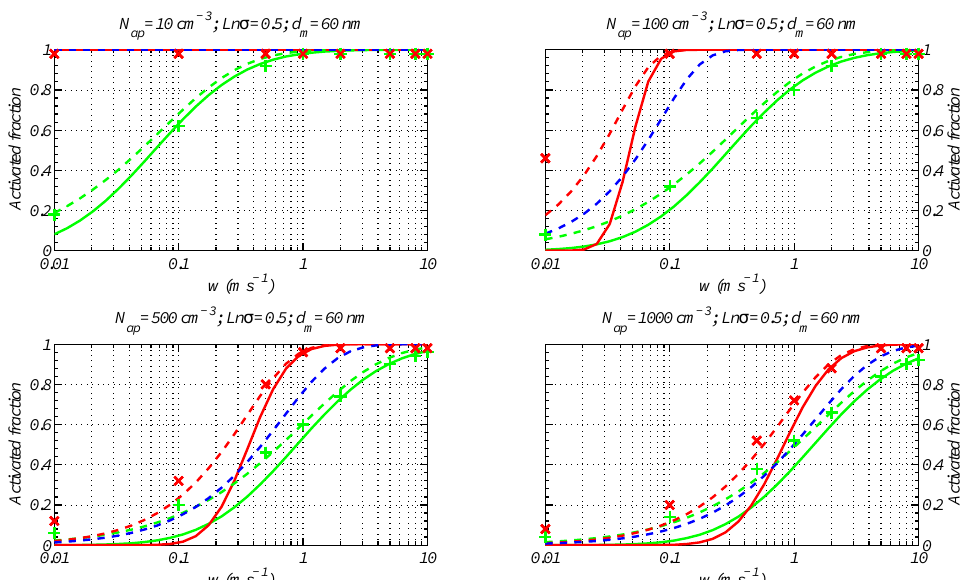
Fig. 6. Comparisons using the “first” type of initialisation (see Section 2.2.2): red and green solid lines show the parcel model with the Abdul-Razzak et al. (1998) implementation for both with and without semi-volatile co-condensation; red and green dashed lines show the same, but for the Fountoukis and Nenes (2005) implementation; and the blue lines are for the Fountoukis and Nenes (2005) implementation, but without the maintenance of arithmetic standard deviation. Top left is for 10cm − 3 total aerosol, top right is for 100cm − 3 , bottom left is 500 cm − 3 and bottom right is for 1000 cm − 3 . Crosses are the parcel model results and lines are the parameterisation. Green lines for without semi-volatile condensation and red (and blue) with.